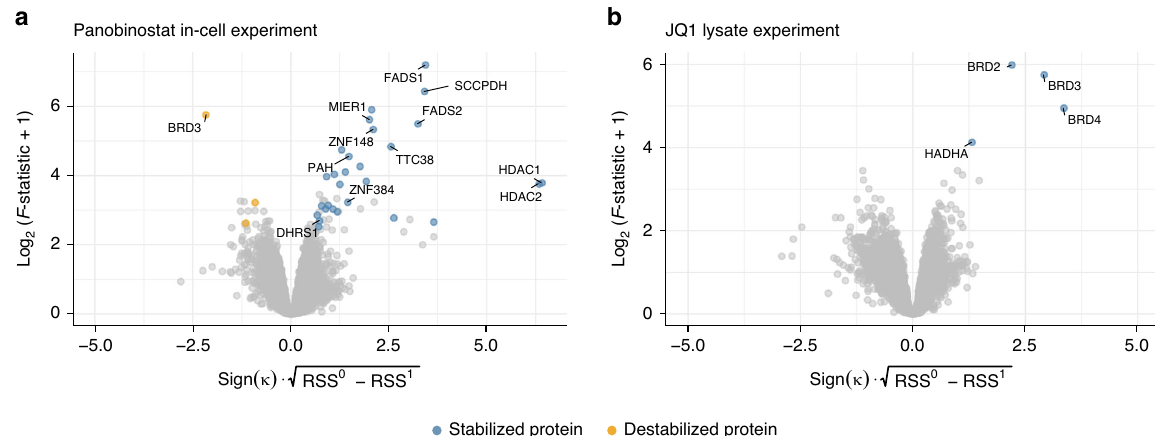
Fig. 3 DLPTP recovers known drug – protein interactions from published datasets. a Volcano plot for the 2D-TPP dataset acquired upon treatment of HepG2 cells with the HDAC inhibitor panobinostat 2 . b Analogous to a , for the JQ1 2D-TPP dataset acquired in THP1 lysate 23 . a , b Blue points represent proteins that were detected as stabilized by the drug treatment and orange as destabilized, at 10% FDR. Axes are outlined in Fig. 1b.